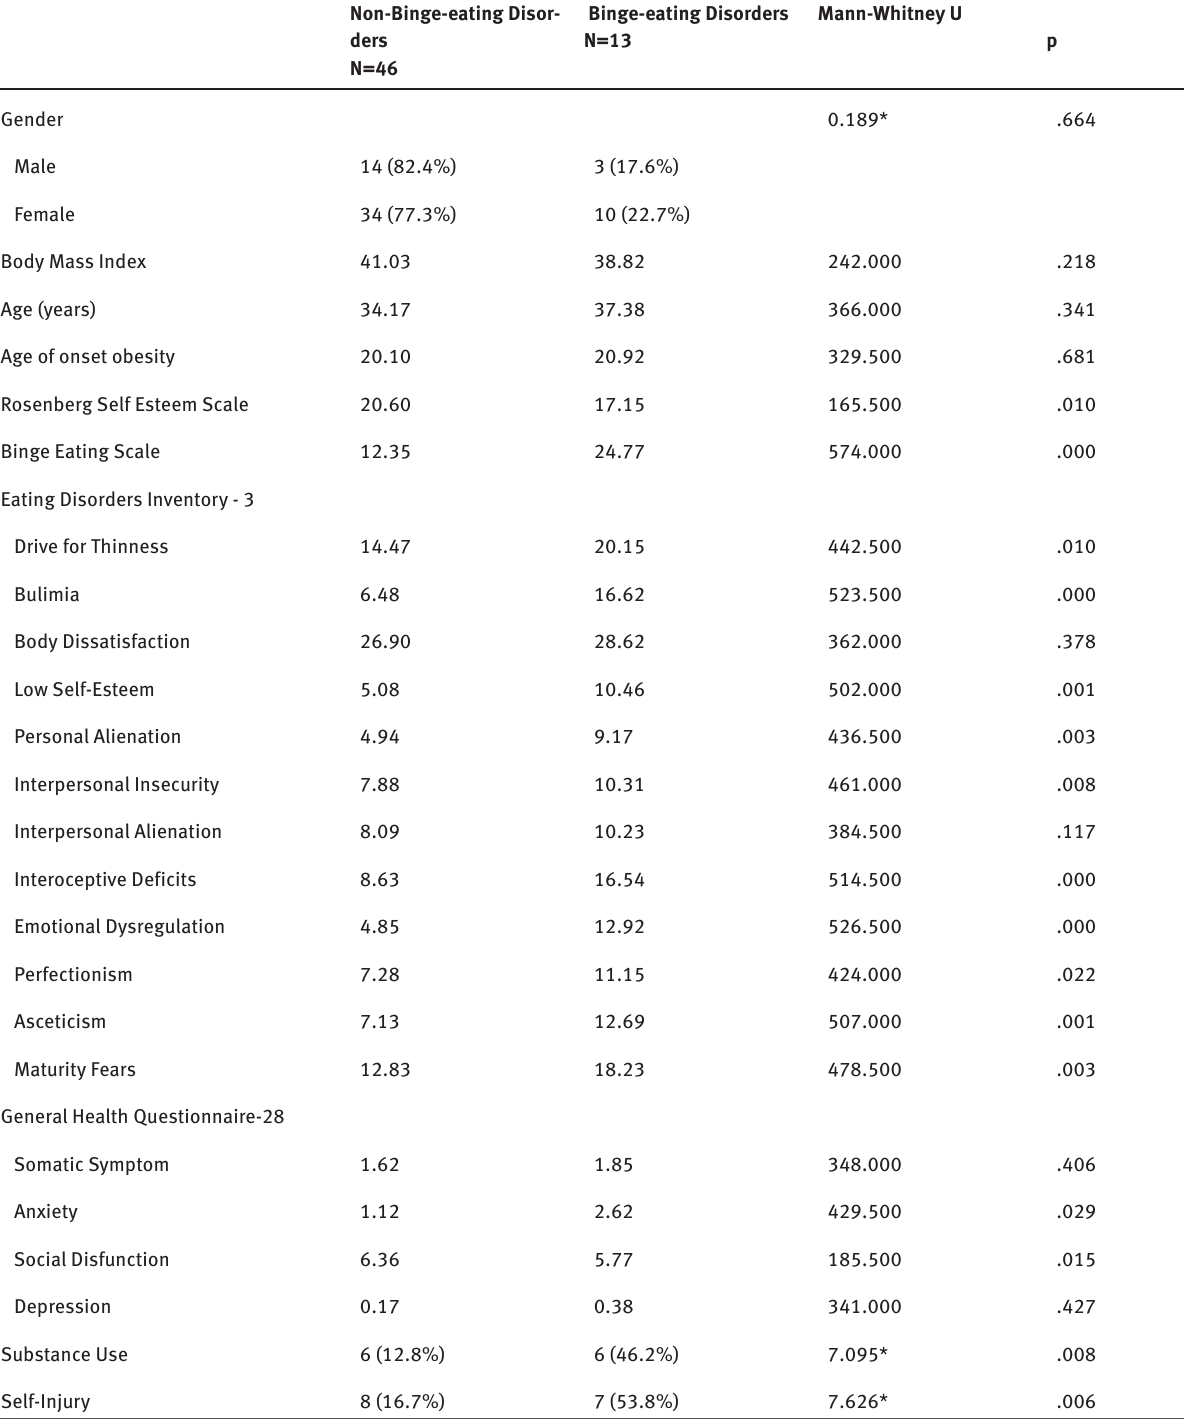
Table 2: Characteristics for binge and non binge-eating disorder group on study variables Non-Binge-eating